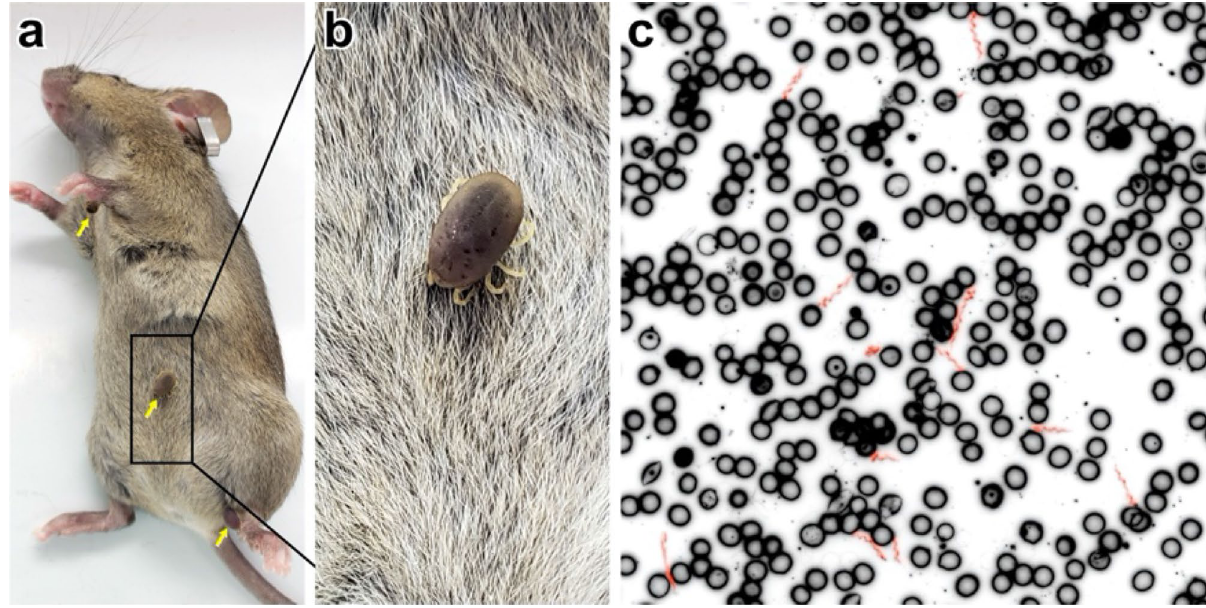
Figure 4. Transmission of B. hermsii by tick bite. ( a ) Three infected ticks (yellow arrows) were allowed to feed to repletion on individual SCID mice. The boxed area is enlarged ( b ) to show a feeding O. hermsi tick. ( c ) Spirochete transmission to the mice was confirmed by visualizing the spirochetes among the red blood cells by thin smear. To enhance visualization of B. hermsii in blood, an inverse image was used and spirochetes were highlighted in red using Adobe Photoshop. Representative images are